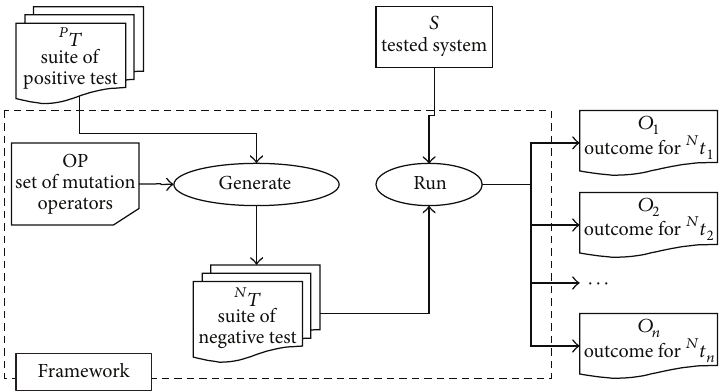
Figure 1: An outline of the